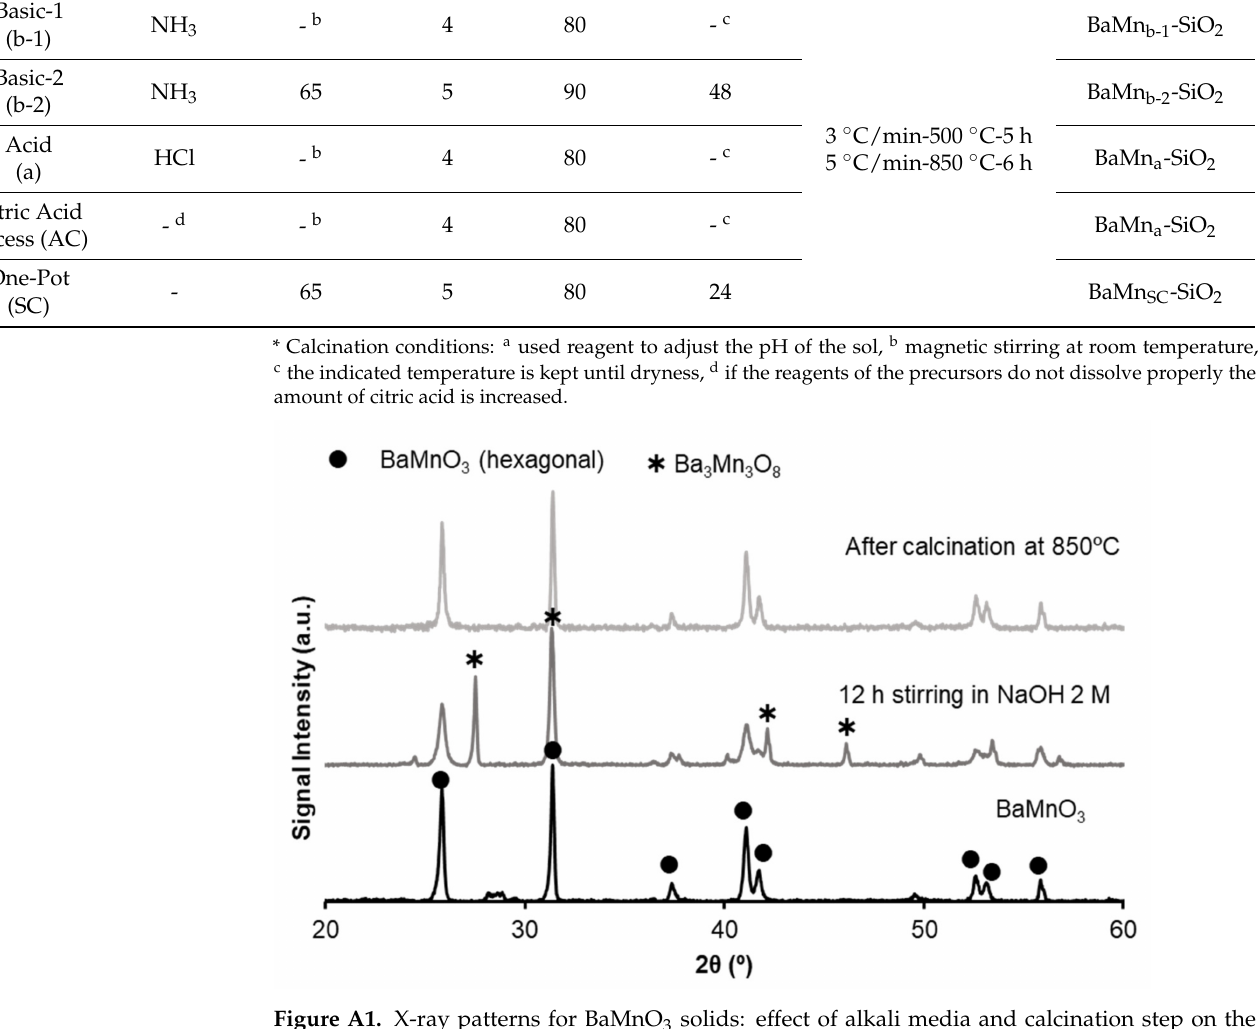
Figure A1. X-ray patterns for BaMnO 3 solids: effect of alkali media and calcination step on the hexagonal perovskite